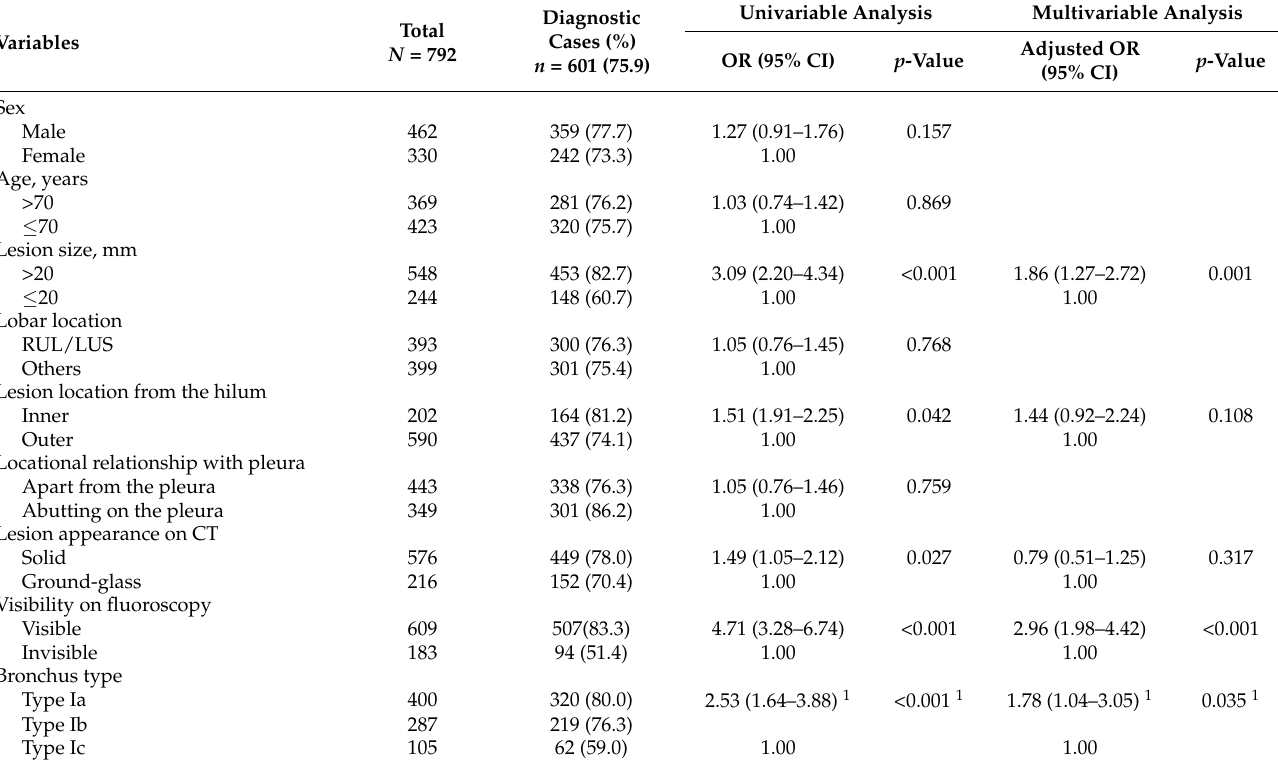
Table 4. Logistic regression analysis of factors affecting successful diagnosis in CT-BS group